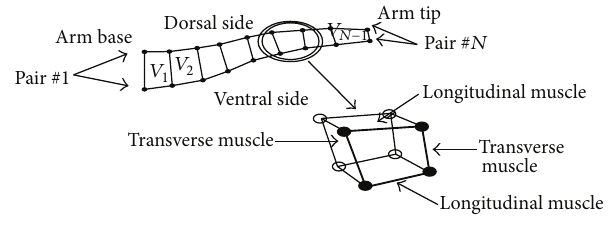
Figure 1: The octopus arm